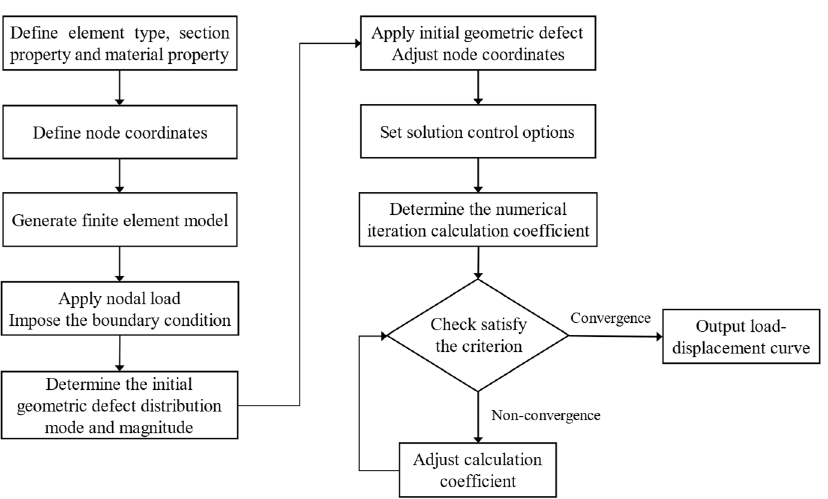
Figure 2. The schematic diagram of static stability analysis for reticulated shell using stochastic defect mode method.